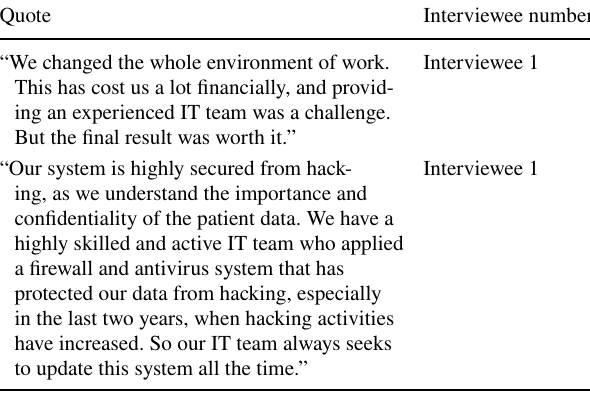
Table 3 Negative effects of IT on healthcare through hacking